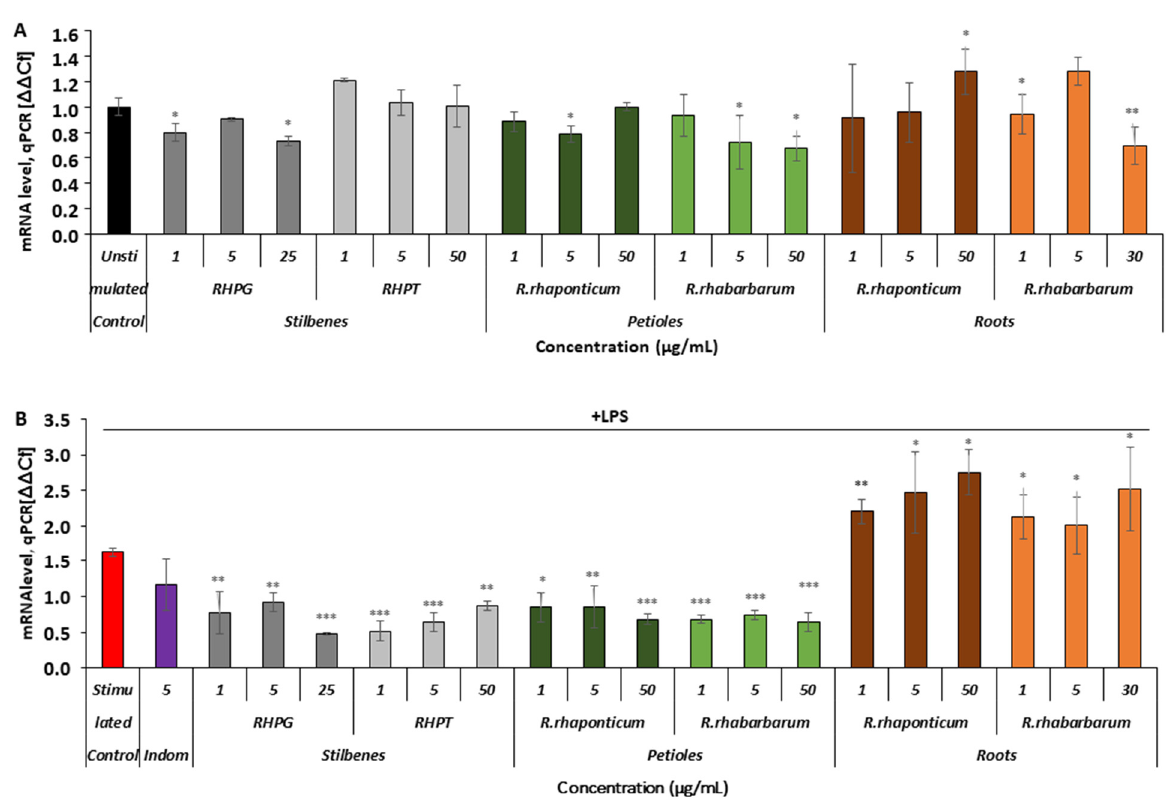
Figure 5. Effects of the rhubarb extracts and stilbenes on COX-2 gene expression in the unstimulated and inflammatory-activated HUVECs. Panel ( A )—data derived from experiments involving HUVECs treated with stilbenes (RHPG and RHPT) or rhubarb extracts, without subsequent pro-inflammatory stimulation with LPS. Panel ( B )—COX-2 gene expression in HUVECs treated with the stilbenes (RHPG and RHPT) or rhubarb extracts and stimulated with LPS; n = 5; * p < 0.05; ** p < 0.01; *** p < 0.001. Indom—indomethacin, a reference compound (COX